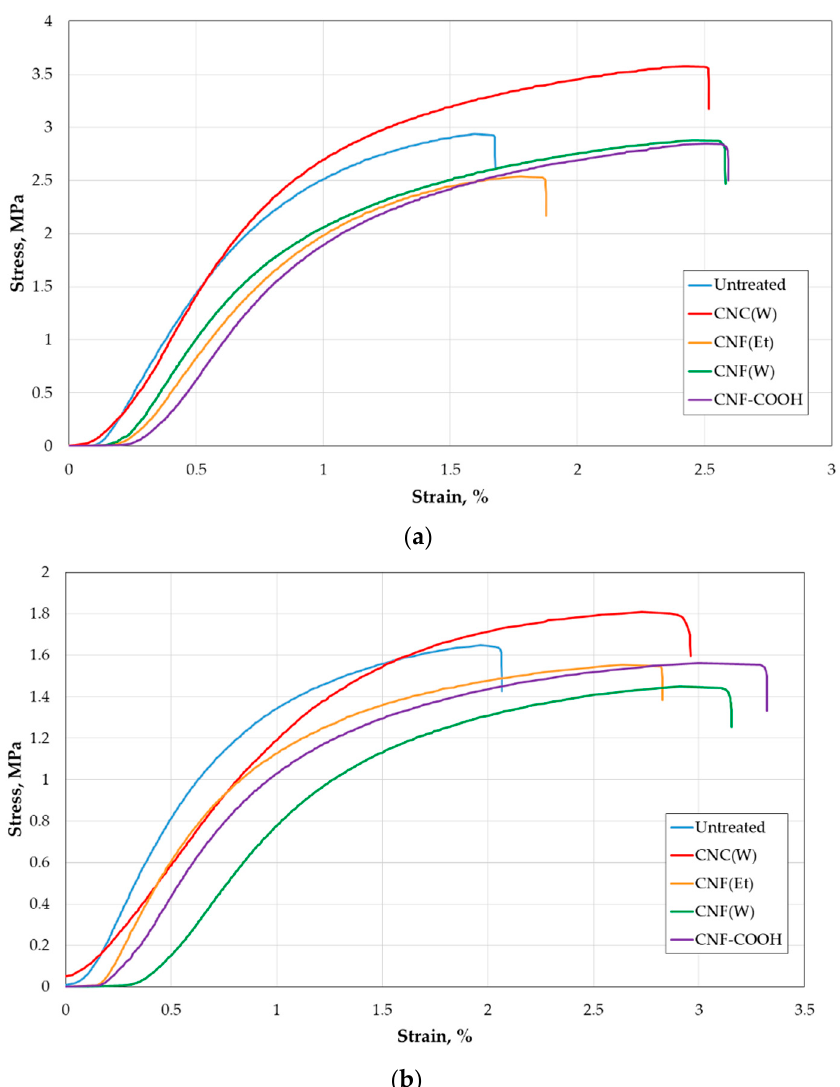
Figure 11. Stress-strain curves of all tested samples: ( a ) MD, ( b ) CD. None of the treated paper was resistant to bending forces. Regardless of the nanocel- lulose used and the web direction, the double-fold number varied from 4 to 8 fold (Figure 12).